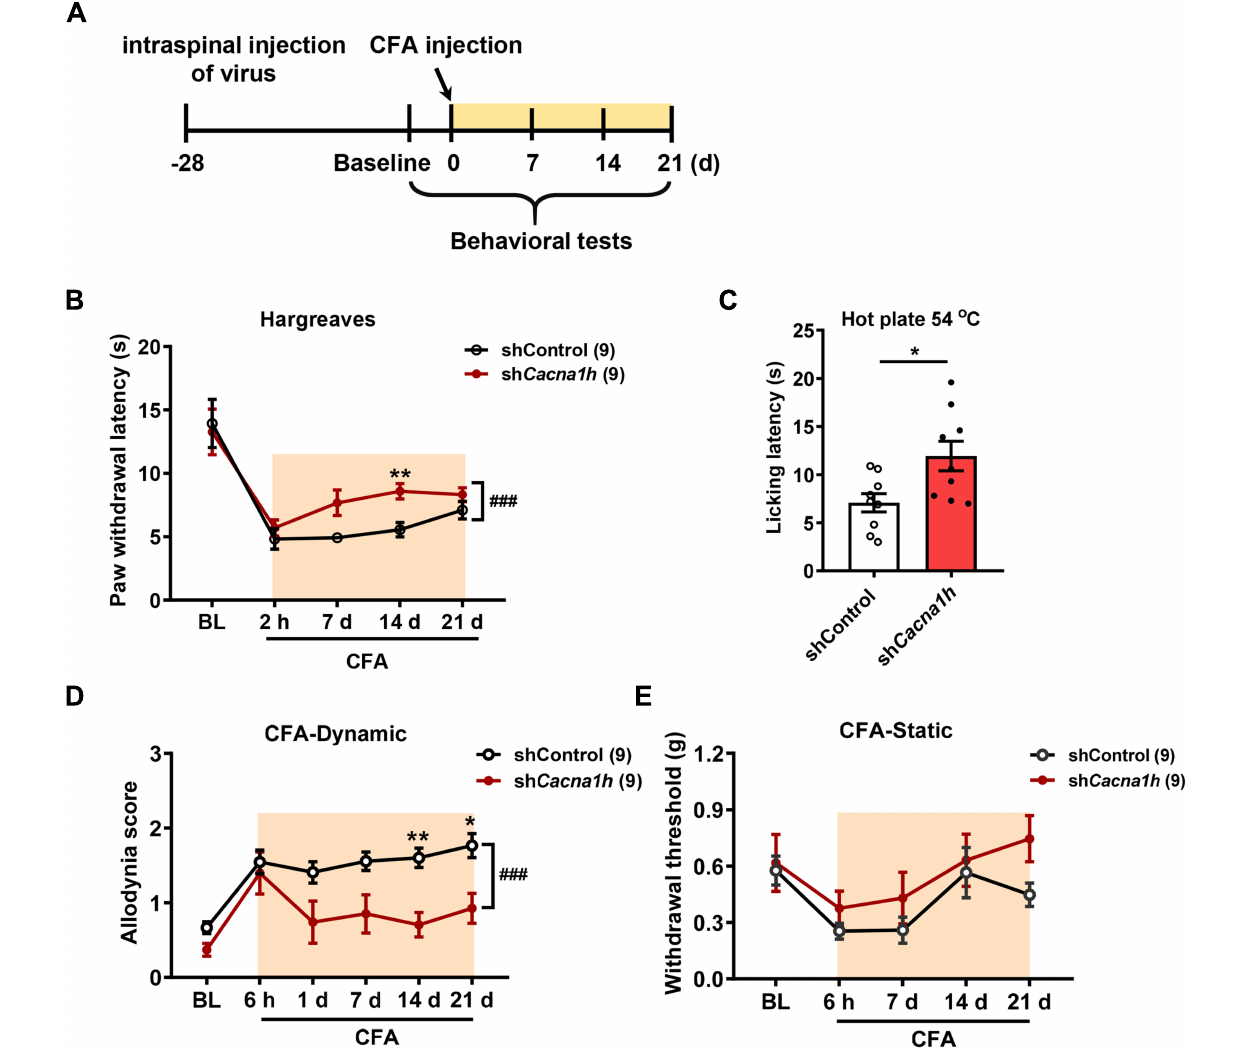
FIGURE 5 | Knockdown of Cacna1h in spinal SOM + neurons attenuated heat hyperalgesia and dynamic allodynia but not static allodynia in a CFA-induced chronic inflammatory pain model in mice. (A) Schematic illustration of the timeline of virus injection, model establishment and behavioral tests. Non-silence shRNA virus was used as a control. (B) The withdrawal latency in the Hargreaves test was increased after Cacna1h knockdown in spinal SOM + neurons in the CFA model. ### P < 0.001, two-way ANOVA with Sidak post hoc analysis. ** P < 0.01, difference between the two groups at the corresponding time points. (C) Licking latency in the hot plate of 54 ◦ C was elongated by Cacna1h knockdown in spinal SOM + neurons at 7 days post CFA injection. * P < 0.05, Student’s unpaired t -test. (D,E) The dynamic allodynia score was reduced (D) , but the static allodynia reflected as the 50% withdrawal threshold was not affected (E) by Cacna1h knockdown in spinal SOM + neurons in the CFA model. ### P < 0.001, two-way ANOVA with Sidak post hoc analysis. * P < 0.05, ** P < 0.01, difference between the two groups at the corresponding time points. BL,